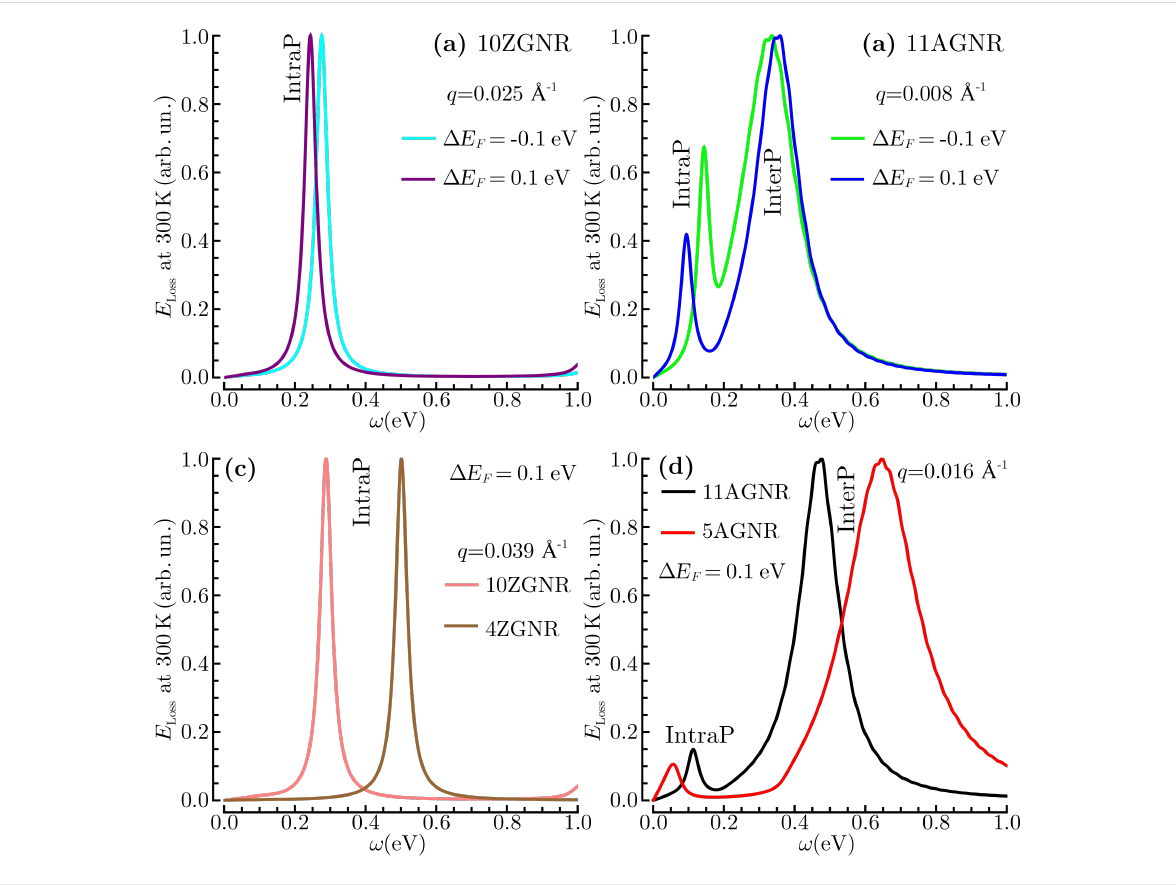
Figure 4: EL function of Equation 8 at room temperature for the GNR-arrays considered in the main text, e.g., 10ZGNR (a), 11AGNR (b), 4ZGNR (c) and 5AGNR (d), being subject to doping levels Δ E F of ±0.1 eV. E LOSS is plotted in the energy range ω ≤ 1 eV at some fixed transferred momentum values, q = 0.025 Å -1 (a), 0.008 Å -1 (b), 0.039 Å -1 (c), 0.016 Å -1 (d), parallel to Γ X (Figure 2g). The intraband and interband plasmons are denoted as IntraP and InterP, as in Figure 2 and Figure